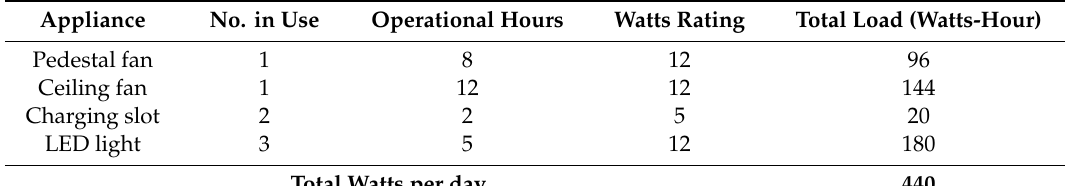
Table 1. Projected load requirement per